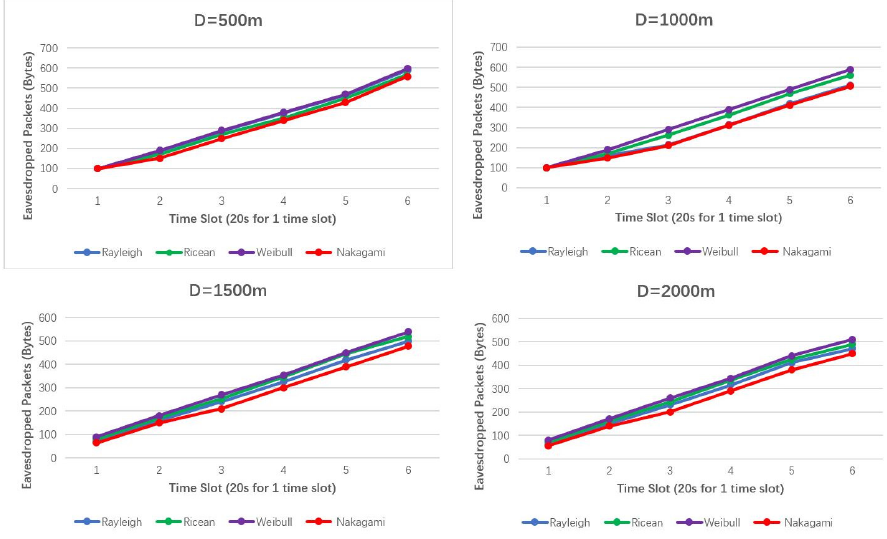
Figure 9. Eavesdropped packets by UAV L in different Ds under different fading channels.